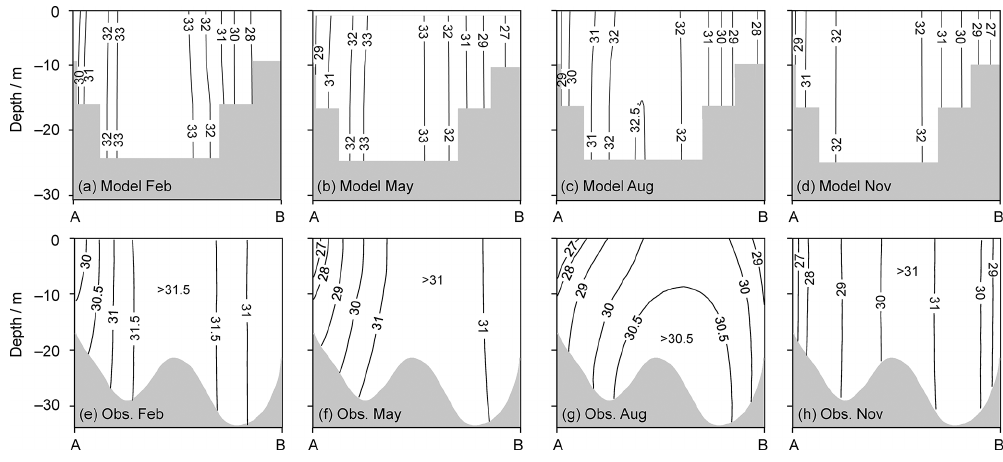
Figure 7. Similar to Fig. 6 but for salinity (PSU).